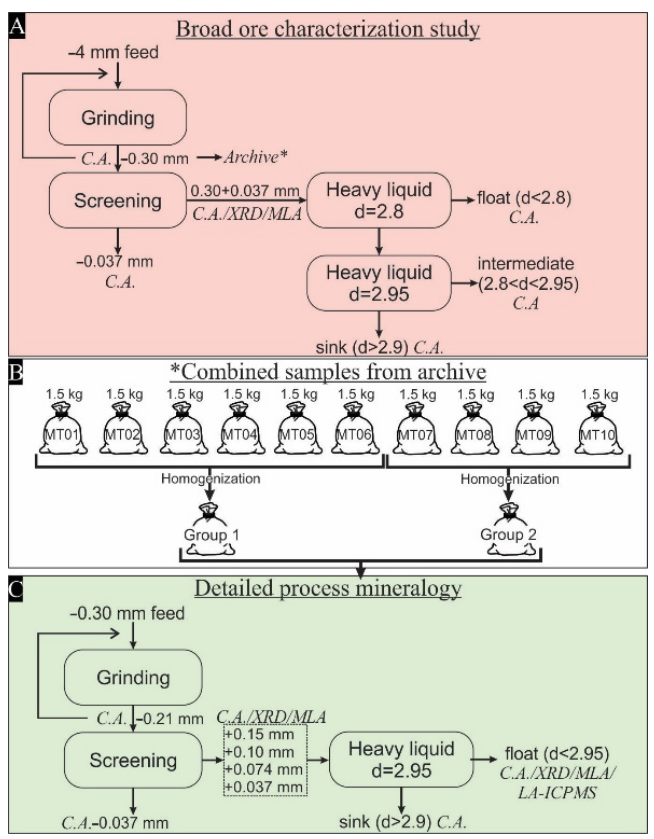
Figure 2. Experiment flowchart: ( A )—Broad ore characterization study performed on 10 samples. ( B )—Ten samples combined into two groups based on the results of the characterization study. ( C )—Detailed process mineralogy study performed on two samples. CA—Chemical analysis; XRD—X-ray diffraction; MLA—Mineral liberation analysis; LA–ICPMS—laser ablation inductively coupled plasma mass